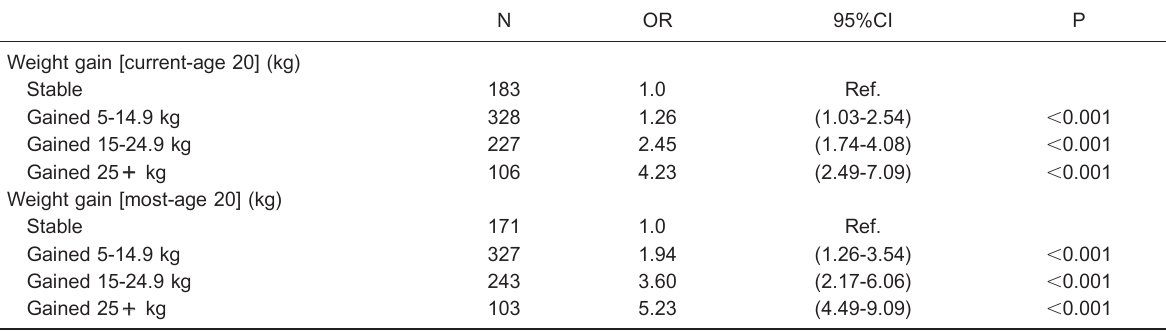
Table 2. Multivariate-adjusted odds ratios (95%CI) for nonalcoholic fatty liver disease by category of adult weight change among 844 residents in Wansong Community from October 2009 to April 2010. N